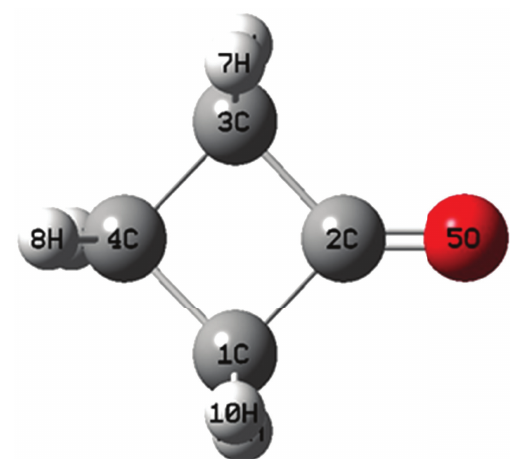
F 2: Model molecular structure of